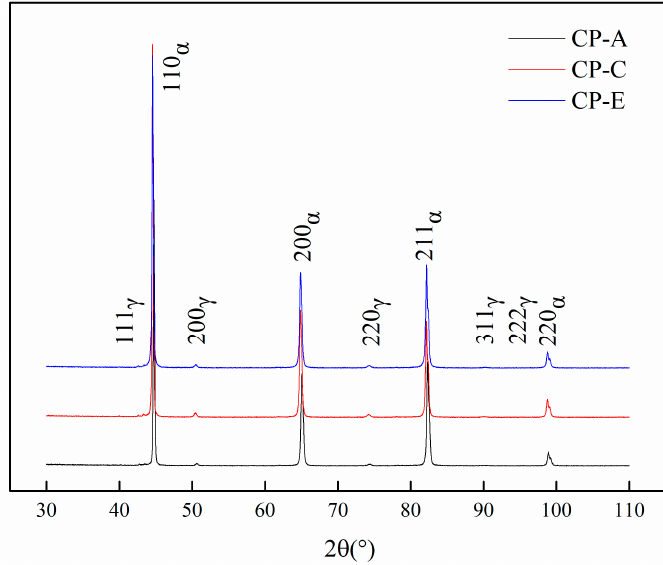
Figure 9. Typical XRD spectra for different CP samples.